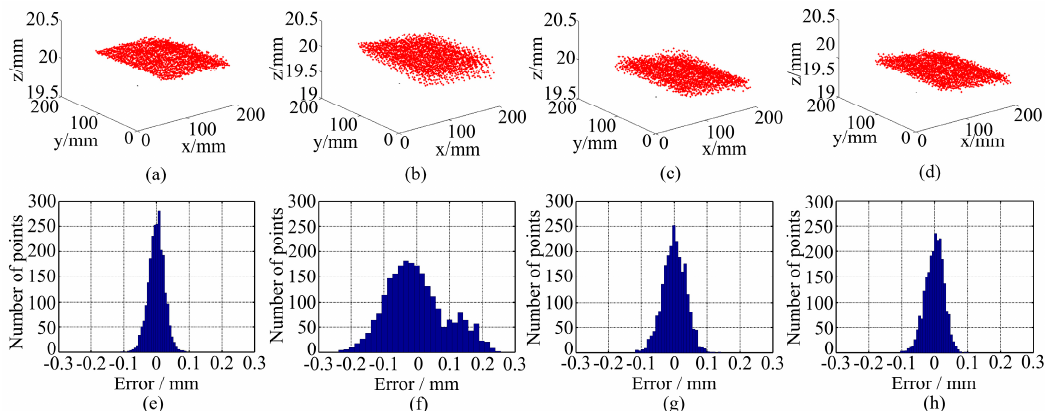
Figure 14. Measurement results of a flat board: 3D point clouds using ( a ) monochrome fringe; ( b ) color fringe pattern without correction; ( c ) the method in Reference [18]; ( d ) the proposed method; measurement error using ( e ) monochrome fringe; ( f ) color fringe pattern without correction; ( g ) the method in Reference [18]; ( h ) the proposed method.